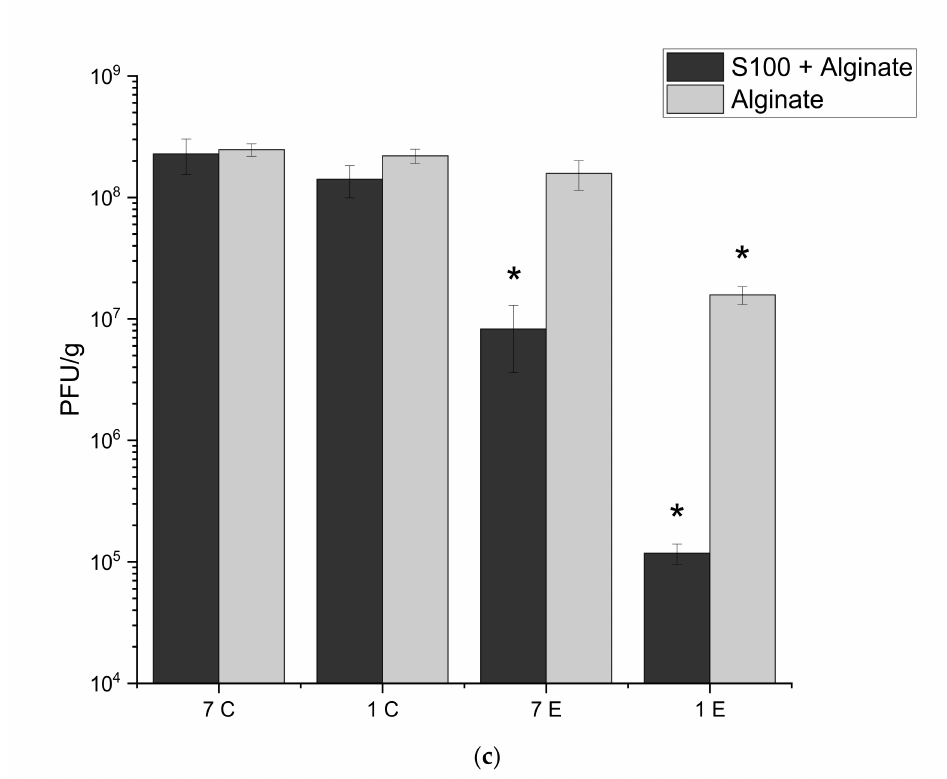
Figure 5. Extrusion of S100+ alginate and alginate only shelled capsules. ( a ) Core-shell capsules were suspended in an oil/flour mixture and extruded using a syringe at a set flow rate of 15 mL/min. ( b ) Pellets with a diameter of 3 mm and an approximate length of 1 cm were produced. ( c ) To determine capsule integrity after extrusion, capsules were harvested from the pellets and exposed to pH 1 buffer (0.2 M NaCl with pH adjusted using HCl) or dissolved using Sorensen’s buffer (pH 7.5). After acid exposure, the capsules were released in Sorensen’s buffer (pH 7.5). Phage concentration was measured using the plaque assay. ‘C’ and ‘E’ encode control and extruded capsules respectively. Error bars represent one standard deviation. * Significantly different phage titres using a paired t- test comparing extruded samples with the control